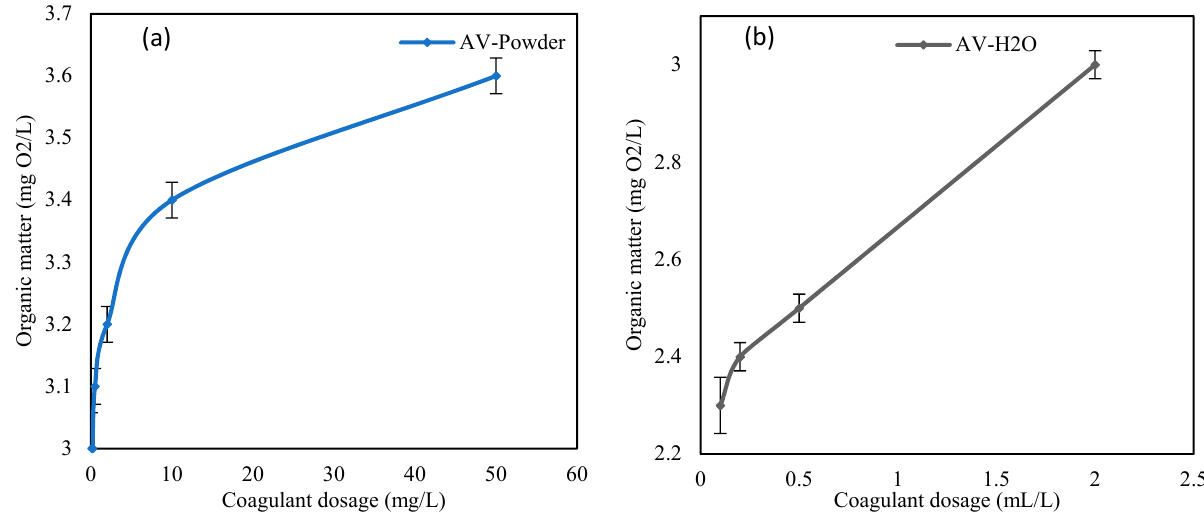
Figure 8. Effect of bio-coagulant dosage on organic matter by using ( a ) AV Powder; ( b ) AV H 2 O.